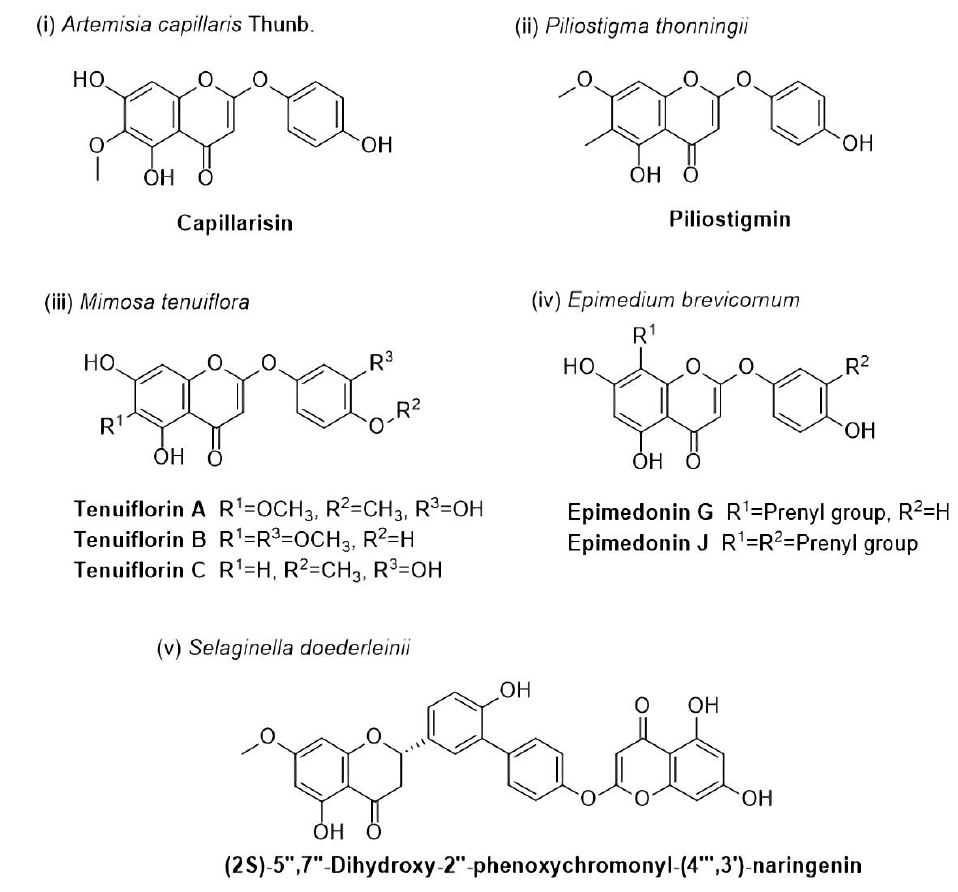
Figure 1. Examples of 2-phenoxychromones in natural products.